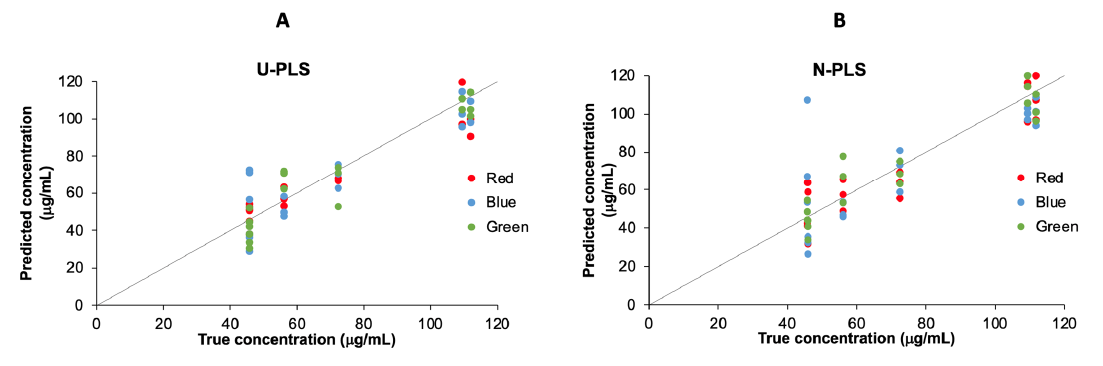
Figure 5. U-PLS ( A ) and N-PLS ( B ) regression line for the regression models obtained in the R, G, and B channels.